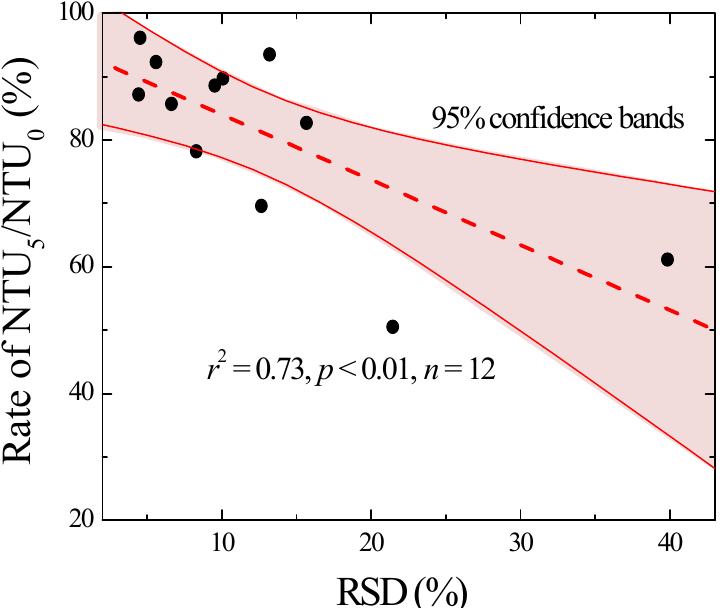
Figure 3. Correlation between the relative standard deviation (RSD, %) and the percent ratio of NTU 5 (turbidity of the sample after 5 min) to NTU 0 (initial).